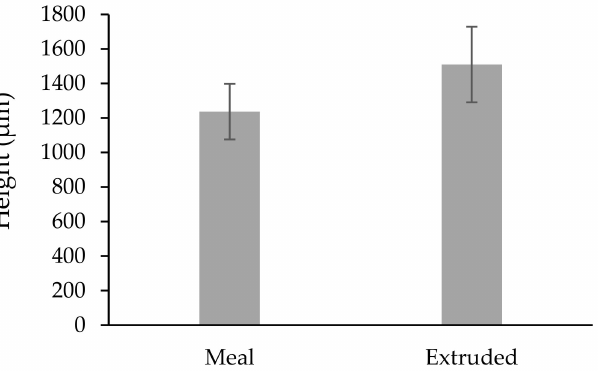
Figure 5. Average height of the rumen papillae under different treatments ( µ m). Shapiro–Wilk test ( p = 0.258).